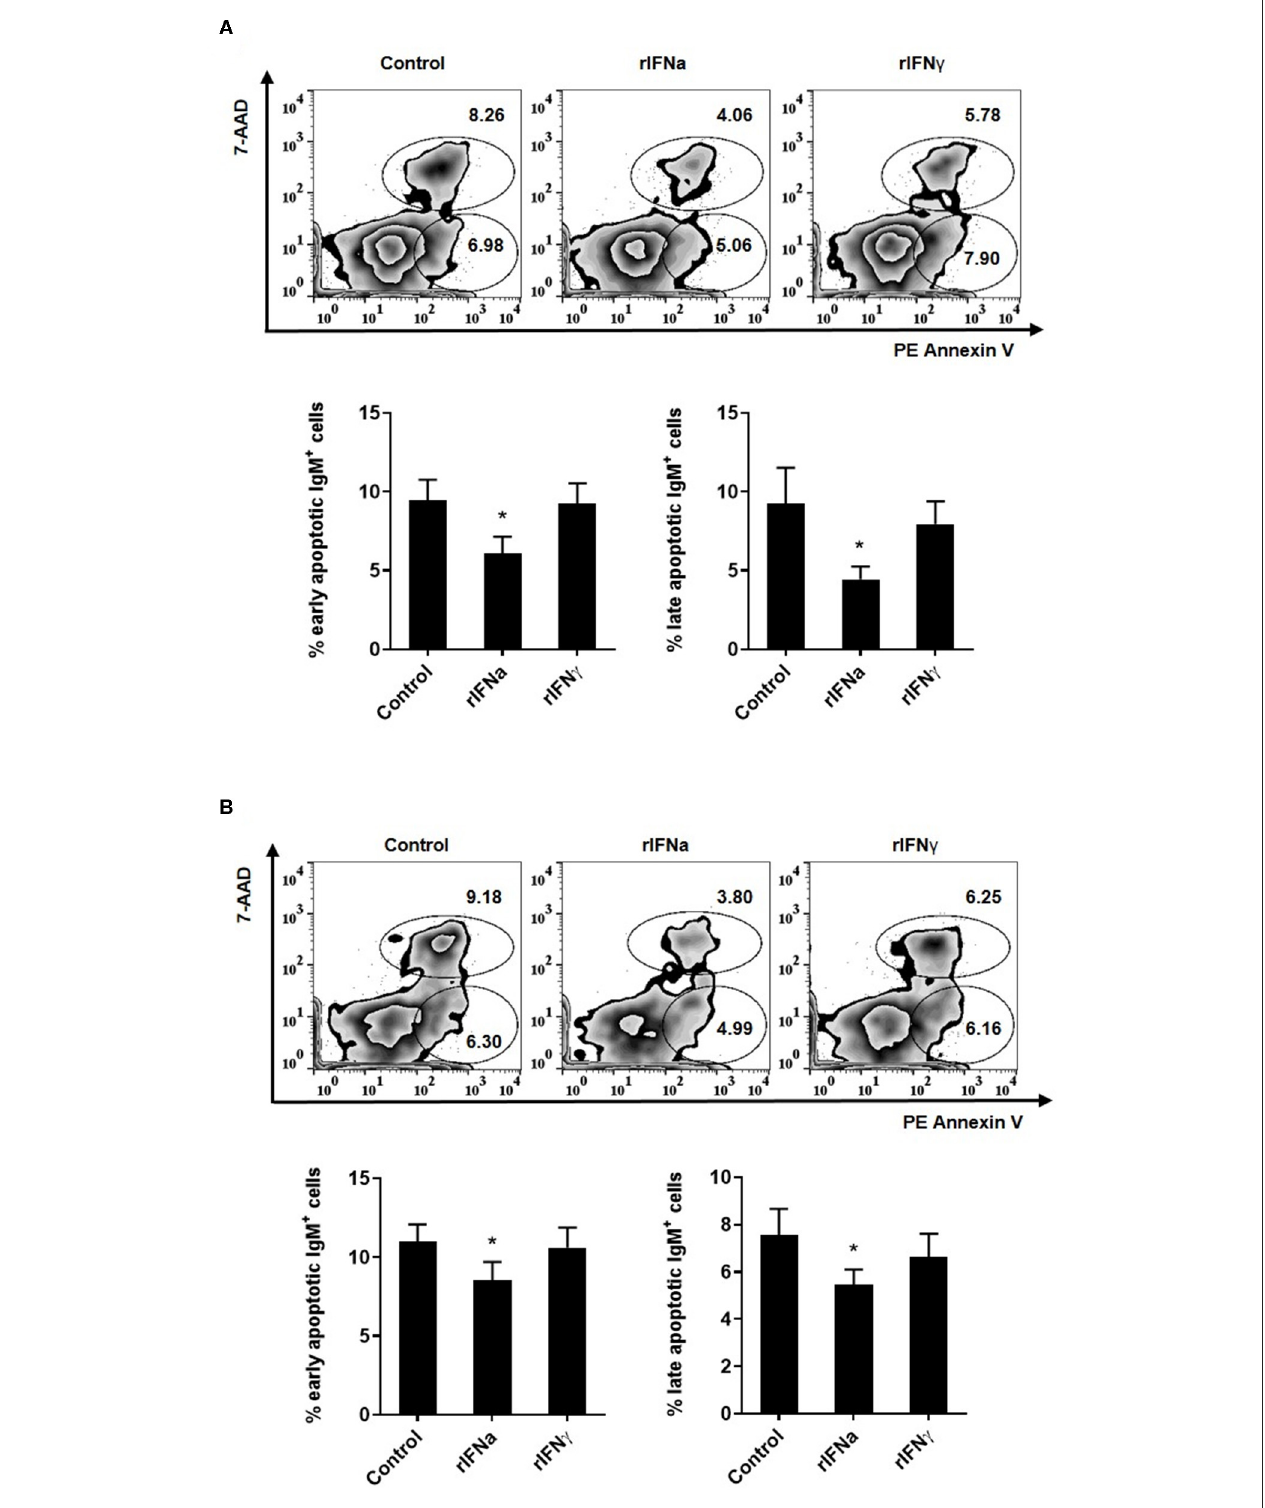
FIGURE 3 | Effect of type I and type II IFNs on the spontaneous apoptosis of blood IgM + IgD + B cells. PBLs were incubated for 48h (A) or 72h (B) at 20 ◦ C with 50ng/ml rIFNa, 20ng/ml rIFN γ or media alone (control). Then, cells were stained with anti-trout IgM for 20min at 4 ◦ C. After washing, PE Annexin V and 7-AAD were